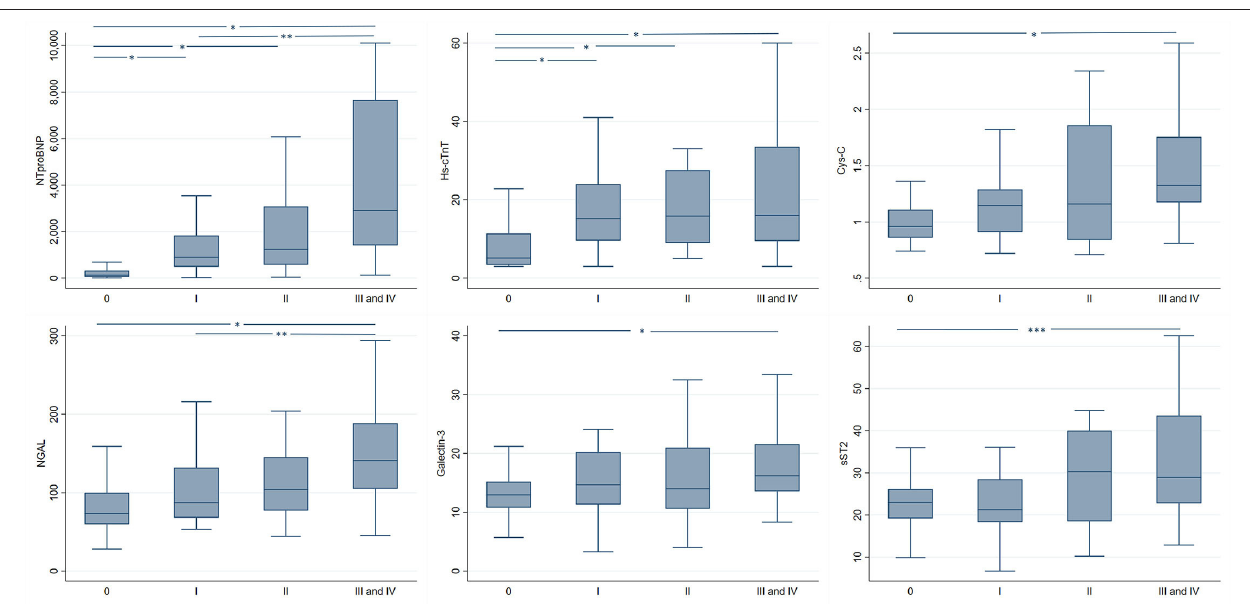
FIGURE 1 | Biomarker levels in patients with chronic Chagas cardiomyopathy with normal and abnormal patterns of diastolic function of the left ventricle. NT-proBNP, N-terminal-proB-type natiuretic peptide; Hs-cTnT, high-sensitive cardiac troponin T; Cys-C, cystatin C; NGAL, neutrophil gelatinase-associated lipocalin; sST2, soluble ST2. *, p-value < 0.001. **, p- value < 0.01. ***, p -value <